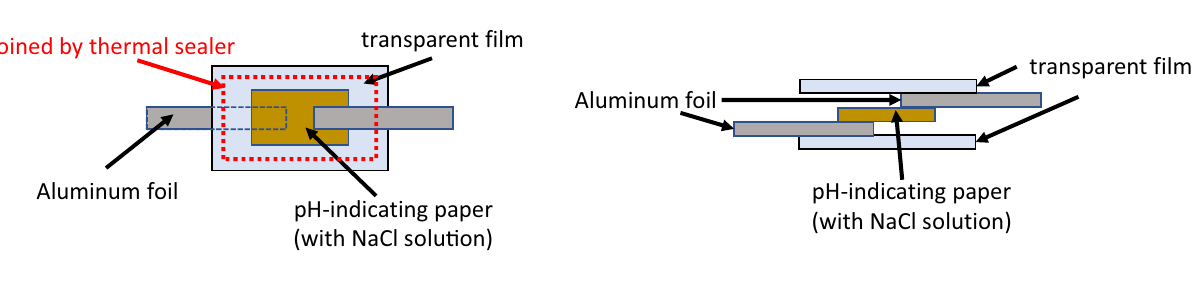
Figure 5. New structure of laminated pH-indicating